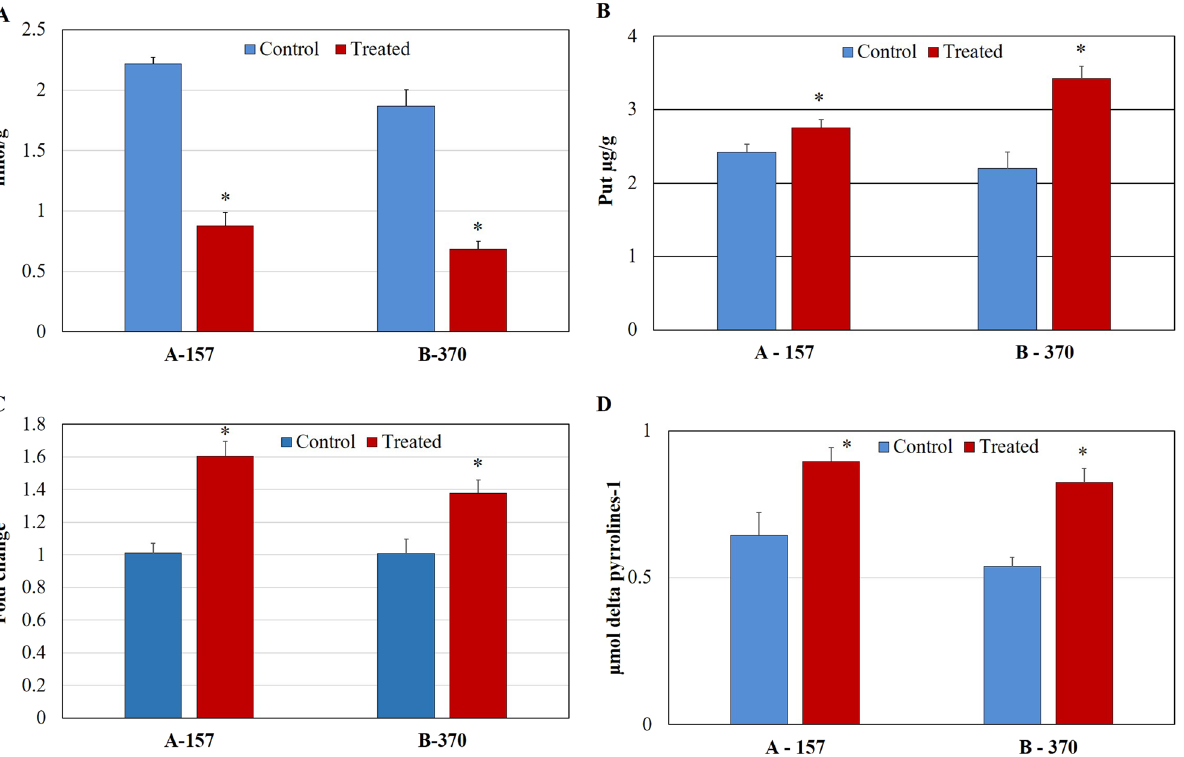
Figure 4. Quantification of ( A ) Putrescine ( B ) ODC enzyme ( C ) ODC gene expression and ( D ) DAO enzyme in the leaf tissue of aromatic rice cultivars grown under control and salt